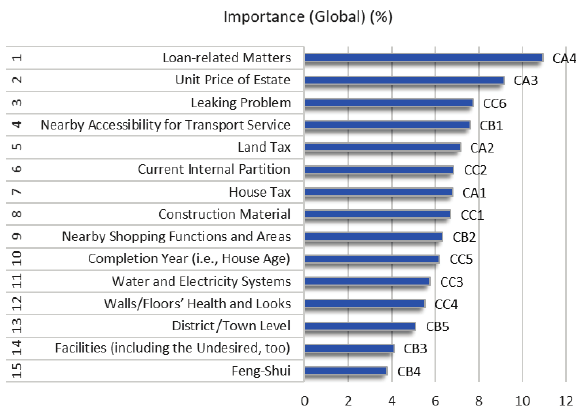
Figure 3. Ranking of individual